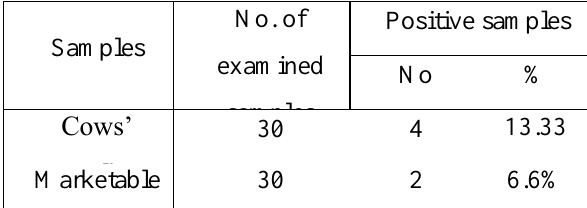
Table 2: Incidence of H. pylori in the